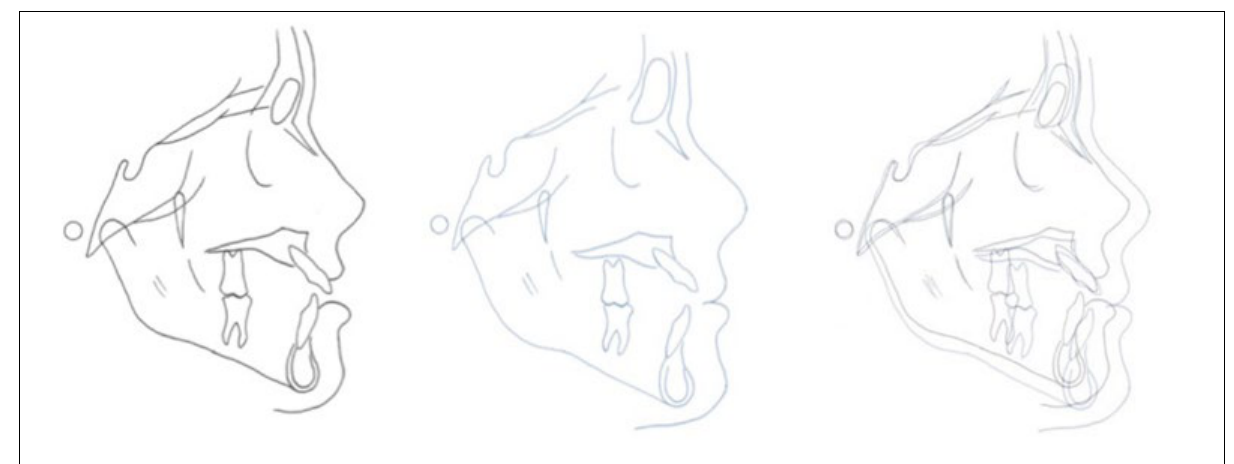
Figure 2a. Initial orthodontic consultation (2008) JCM 12 years old.